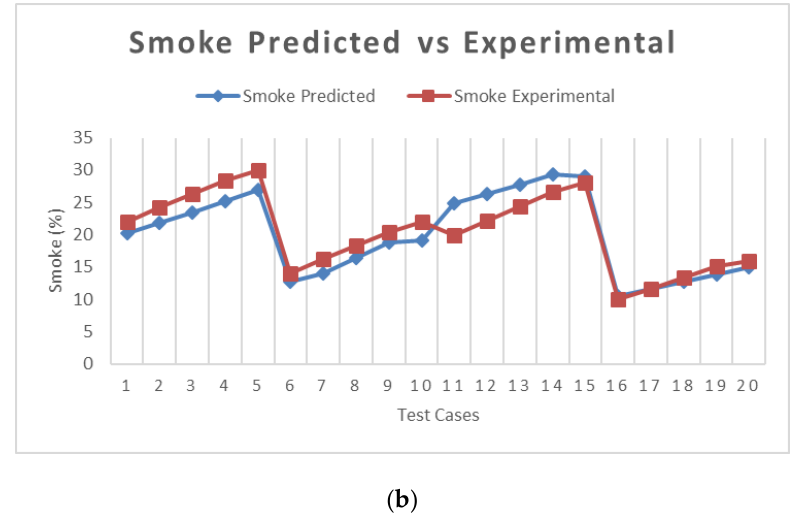
Figure 11. ( a ) Depiction of predicted and experimentally obtained Smoke values taken for 20 test cases; ( b ) Regression coefficient for the values predicted using ANN Vs experimental.